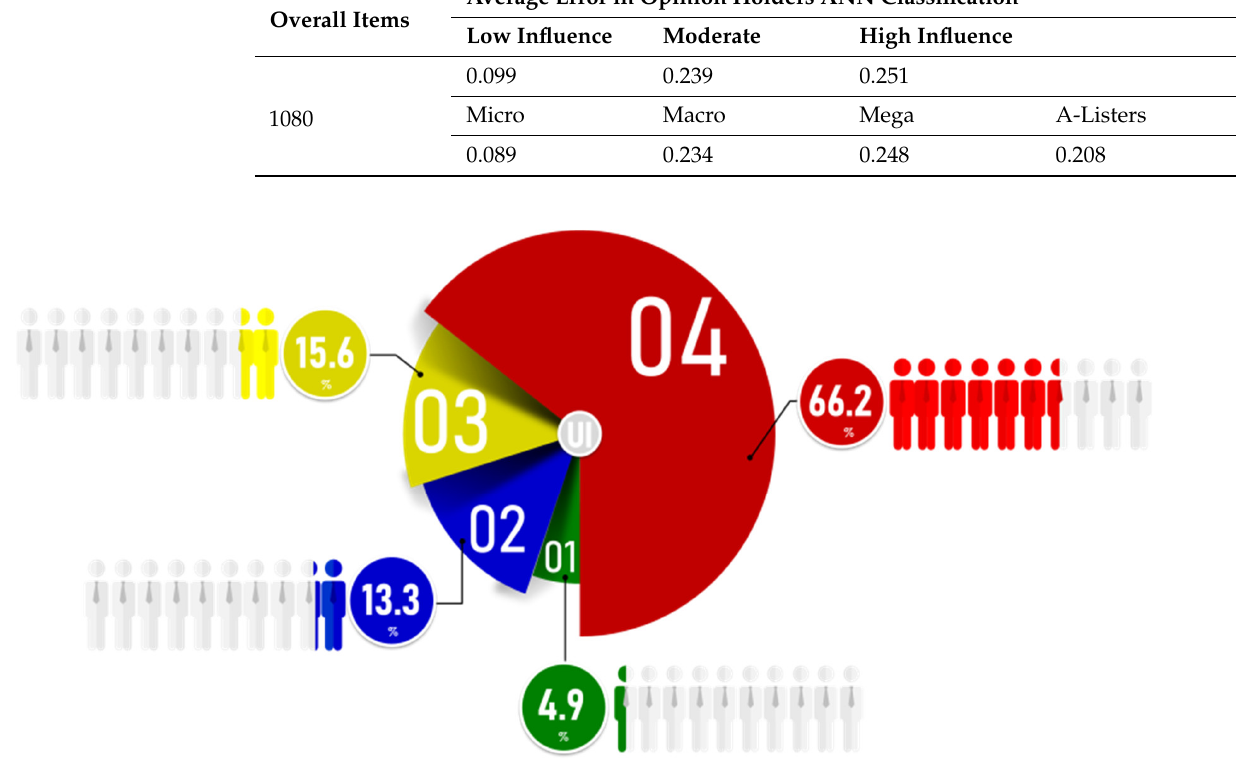
Figure 9. Opinion holders’ classification in the dataset.